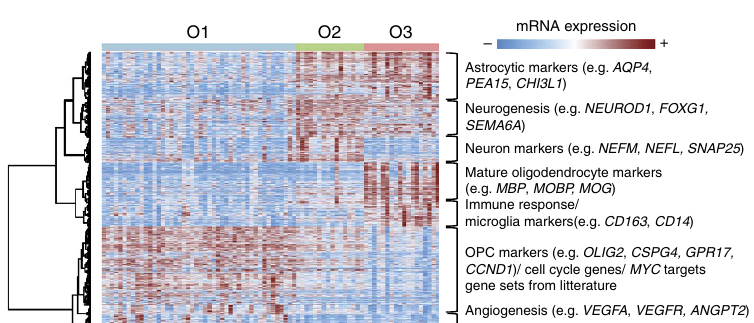
Figure 4 | Heatmap of mRNA expression profile from the top most up-regulated probe sets in each subtype. We performed moderated t -tests to analyse differential expression of Affymetrix HG-U133 Plus 2.0 arrays probe sets in each subtype compared to the others, and selected the top 1,000 probe sets with the highest fold-change among all significantly deregulated probe sets ( P value o 0.05, no adjustments for multiple comparisons). For each of the eight clusters of probe sets highlighted on the heatmap we performed gene-set enrichment analysis and annotated the clusters on the right with the most relevant significantly enriched gene sets (hypergeometric test P value o 0.05) and corresponding relevant gene markers.